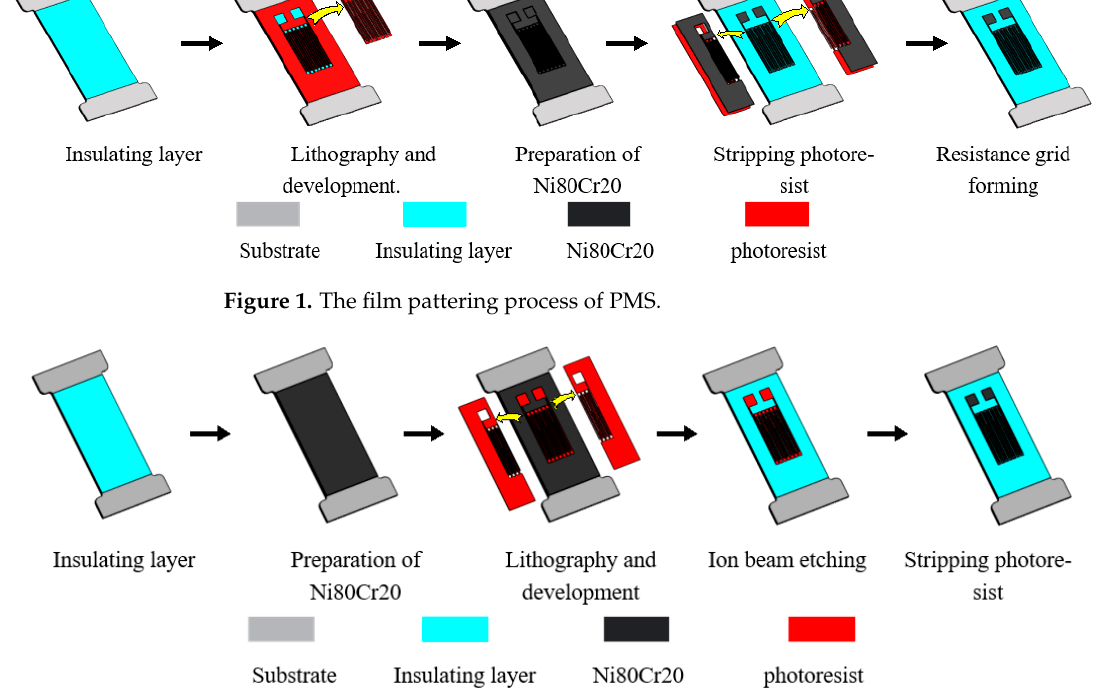
Figure 2. The film pattering process of PIBE.